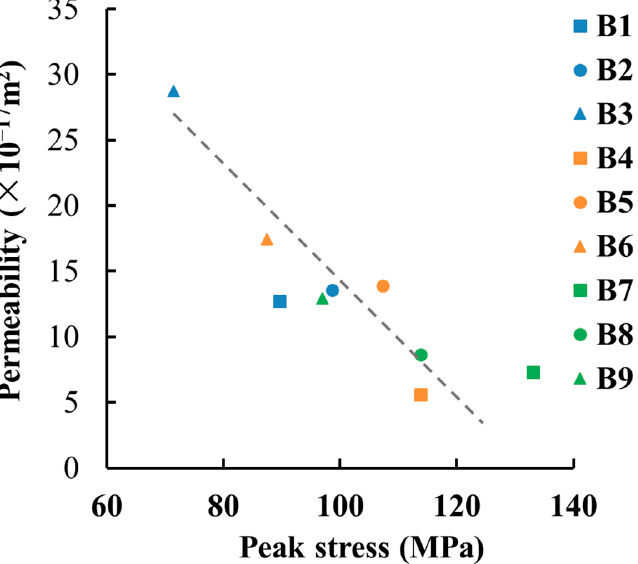
Figure 12. Peak stress and corresponding permeability of sandstone.